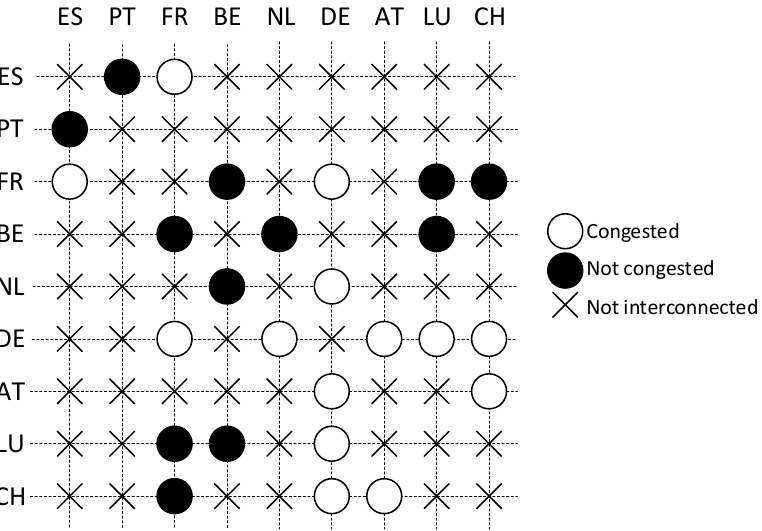
Figure 3. An example of a network configuration: The state of the interconnections corresponding to the representative network configuration 4 in Section